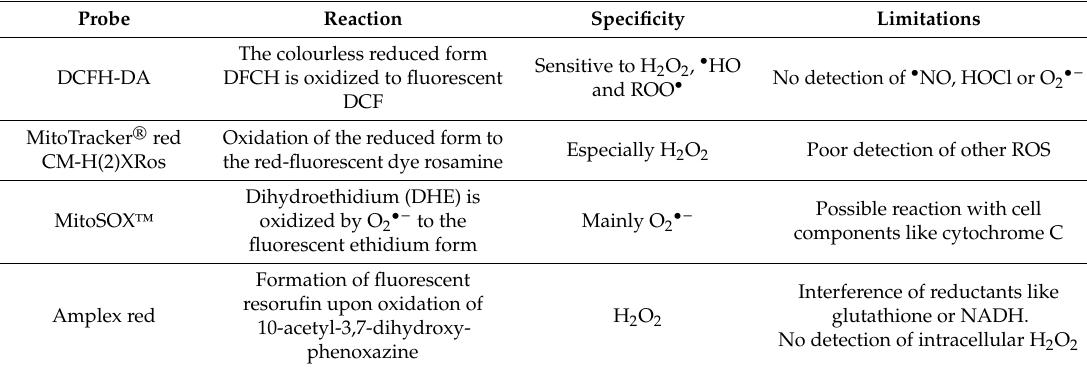
Table 1. ROS determination